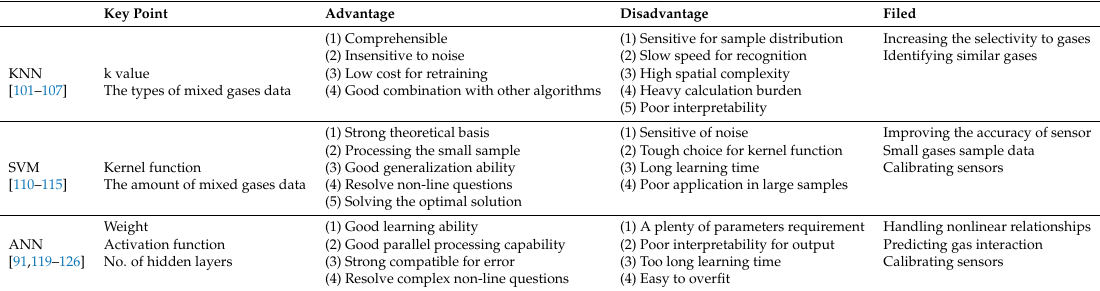
Table 4. Algorithm comparison.